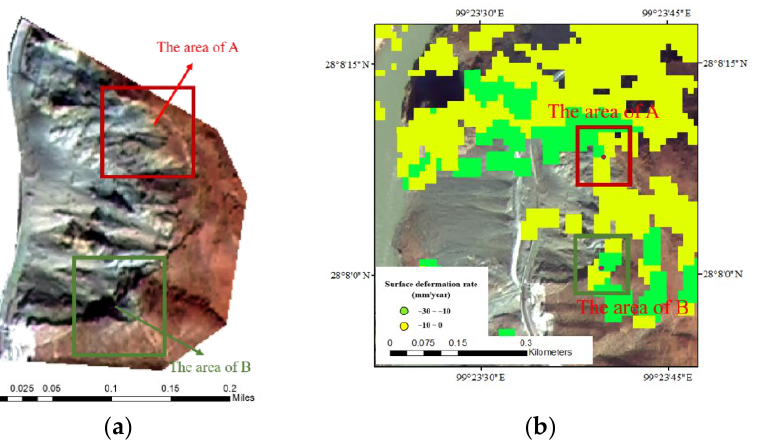
Figure 8. Location maps of the abnormal vegetation area. ( a ) The location on optical GF-1 fused true color image; ( b ) The location on the surface subsidence rate map.